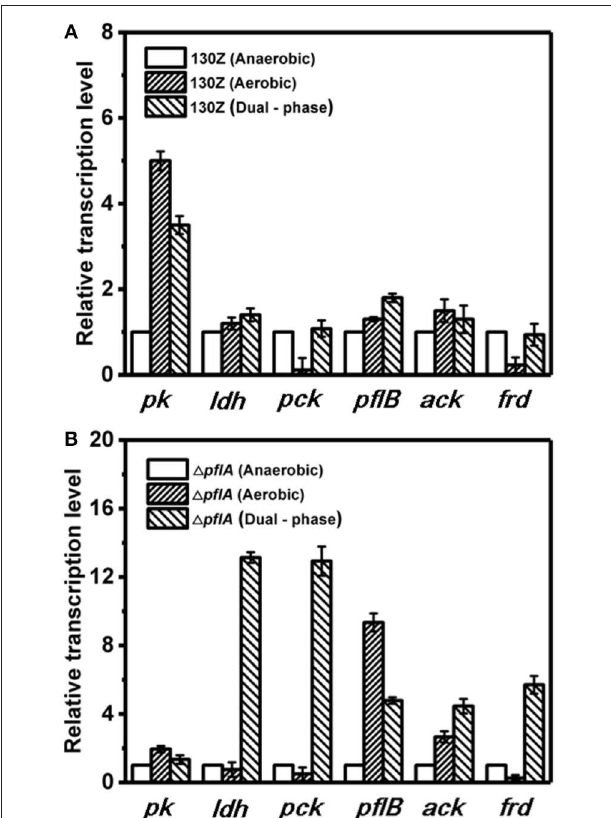
FIGURE 7 | Redistribution of metabolic products by mutant with pflA deletion. Glucose carbon flux in strain 1 pflA under aerobic condition (green) and anaerobic or dual-phase condition